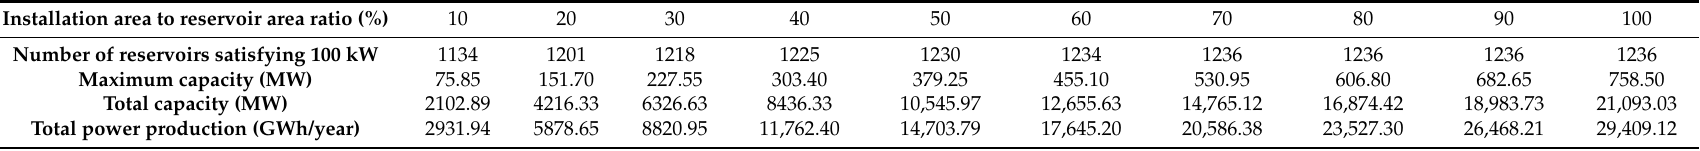
Table 2. The results of floating photovoltaic system installations according to the ratio of the installation area for all reservoirs satisfying the water depth requirements. Installation area to reservoir area ratio (%) Number of reservoirs satisfying 100 kW